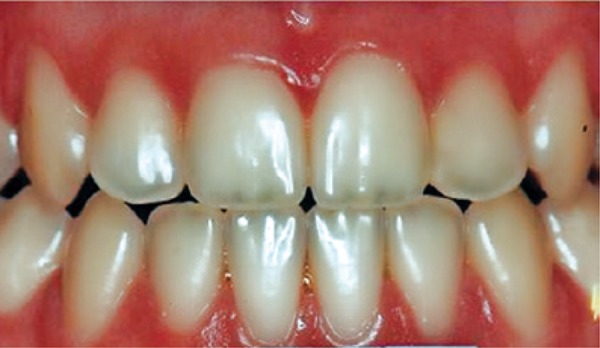
Dentes sem alteração de esmalte